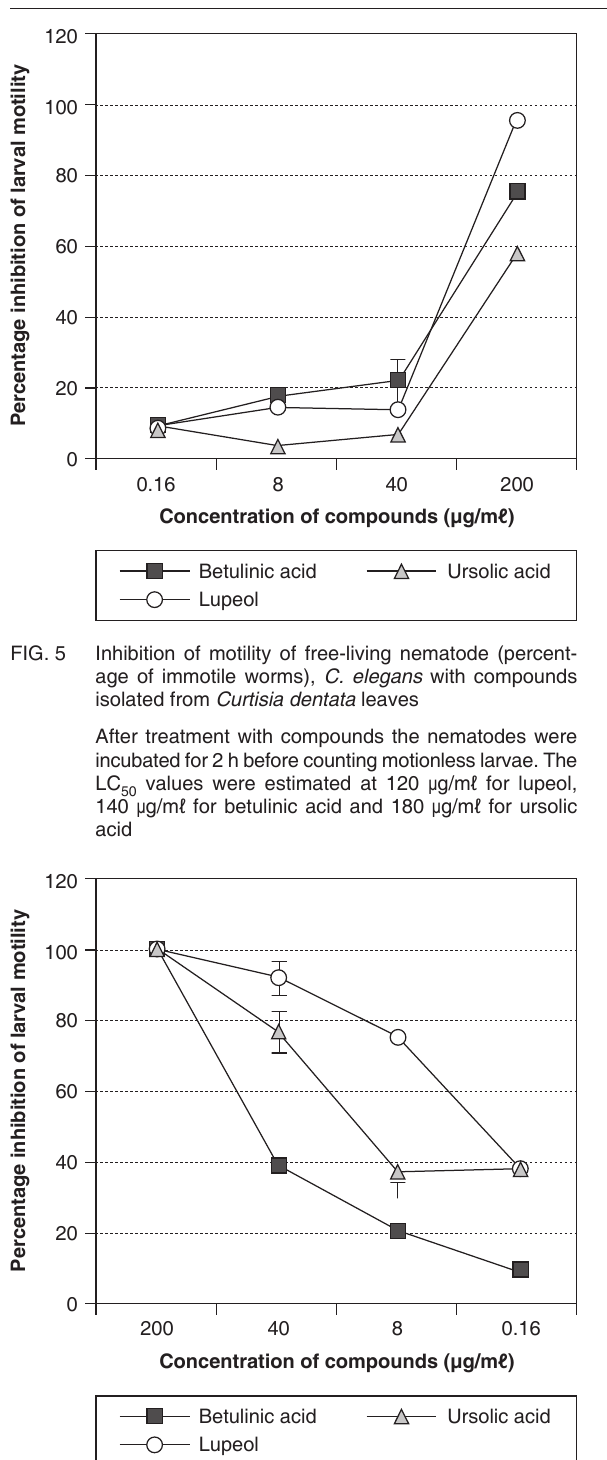
FIG. 8 Inhibition of motility of free-living nematode, C. elegans